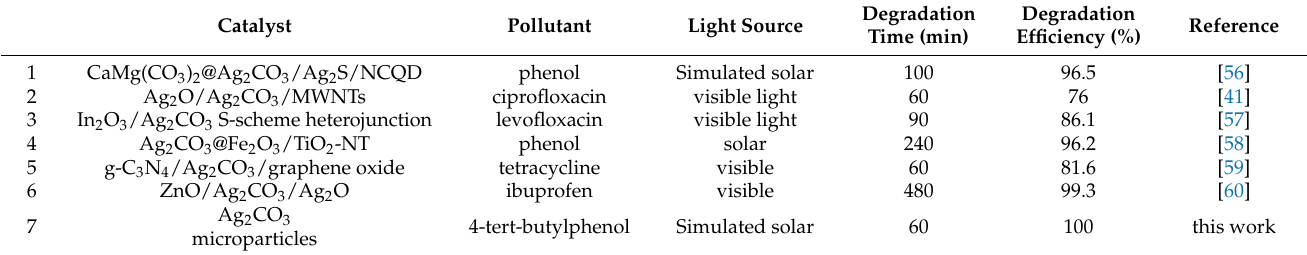
Table 2. The recent application of Ag 2 CO 3 -based catalysts for the degradation of organic compounds in water, under light